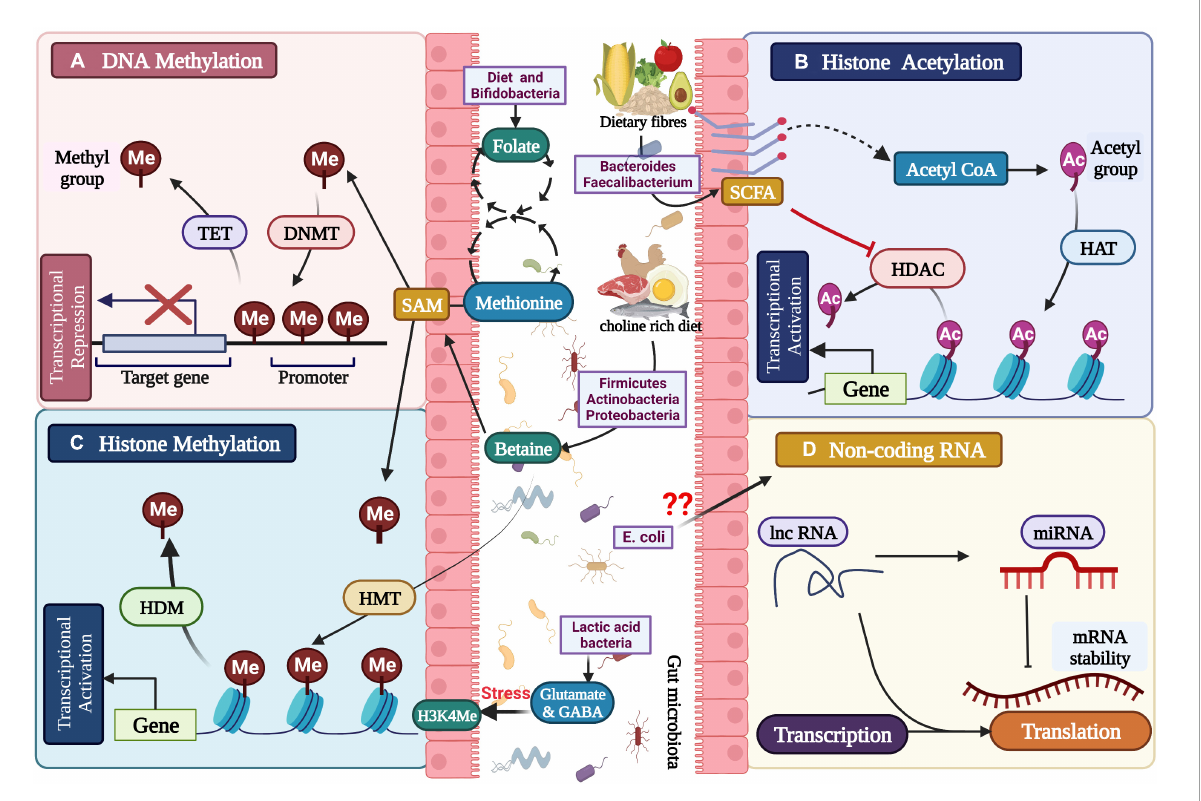
FIGURE2 Gut microbial metabolites regulating the epigenetic mechanisms: (A) DNA methylation, (B) histone modification, (C) histone methylation, and (D) non-coding RNA associated gene silencing.